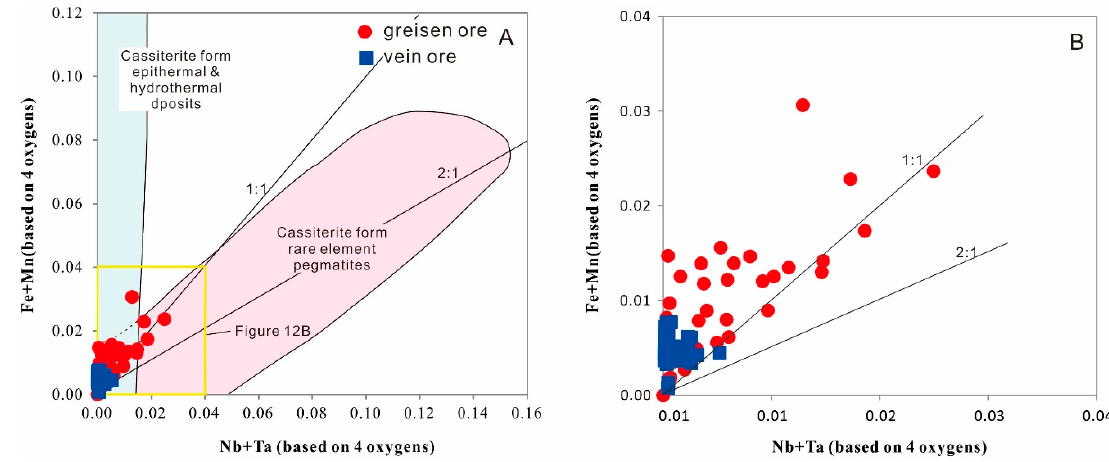
Figure 12. Covariation plot of Nb + Ta with Fe + Mn in cassiterite grains from the Maoping W–Sn deposit (modified from [76]). ( B ) is the yellow box area of ( A ).